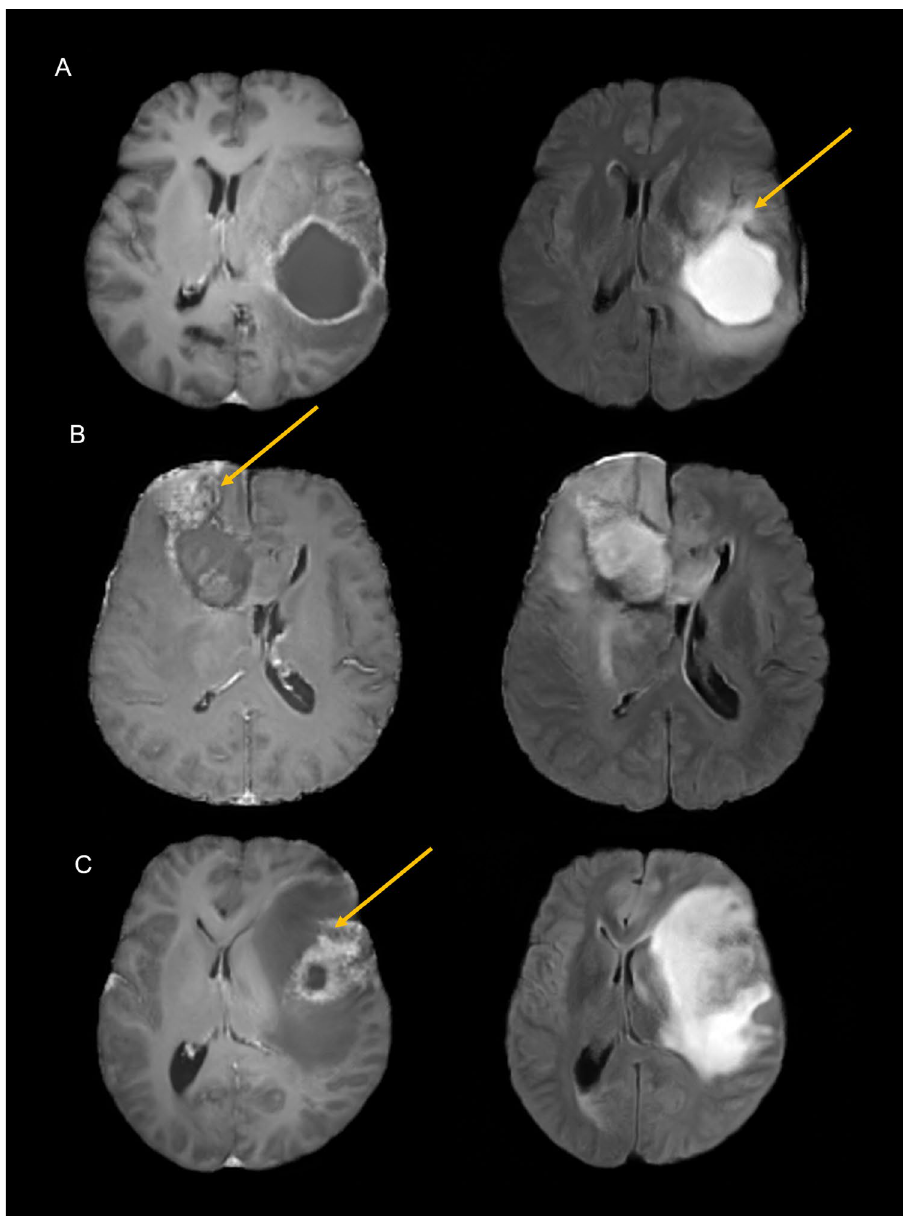
Figure 3. Representative synthetic images correctly determined to be synthetic by neuroradiologists. ( A ) Contrast-enhanced T1-weighted (CE-T1w) image similar to a real image, coupled with a FLAIR image showing an open rim of hypointensity, suggesting that the image was not real. ( B ) CE-T1w images showing nodular enhancement with a mesh-like artifact, suggesting that these images were not real. ( C ) CE-T1w images showing bizarre-shaped linear enhancement, suggesting that these images were not